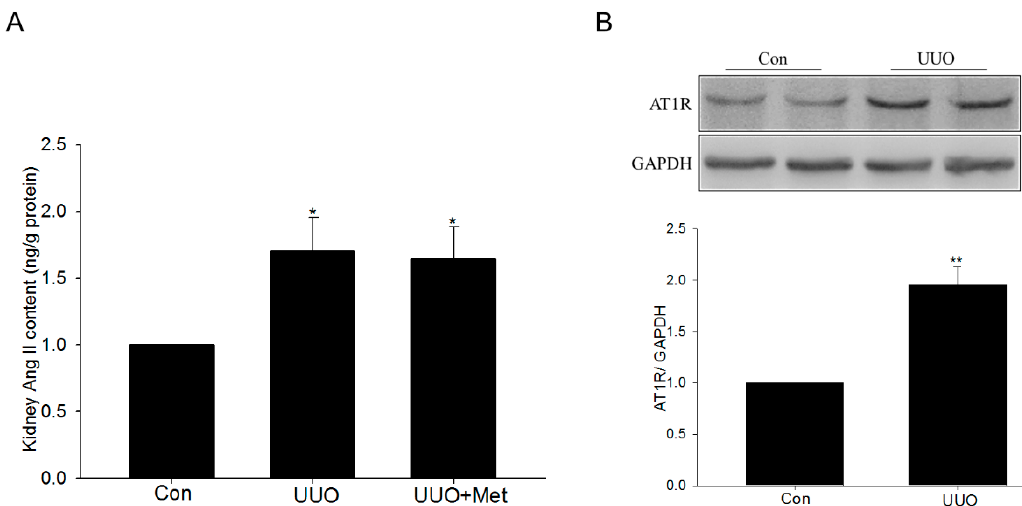
Figure 6. The activation of renin-angiotensin system in UUO mice. ( A ) The level of angiotensin II was detected using an ELISA kit; ( B ) The levels of AT1R were analyzed by Western blotting. Data are the mean ± SEM of six animals. * p < 0.05, ** p < 0.01 compared with control (Con).